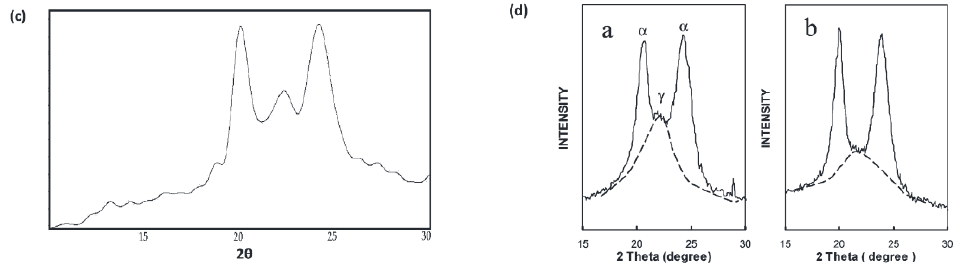
Figure 5. Wide-angle X-ray diffraction (WAXD) diffractograms for as-received cage α –CD ( a ), stoichiometric 1:1 nylon-6– α –CD IC ( b ), 3:1 (n-s) nylon-6– α –CD IC ( c ), and ( d ) as-received nylon-6 (left) and nylon-6 from its stoichiometric 1:1 nylon-6– α –CD IC (right). Reproduced from [8] with permission, copyright American Chemical Society, 2009.